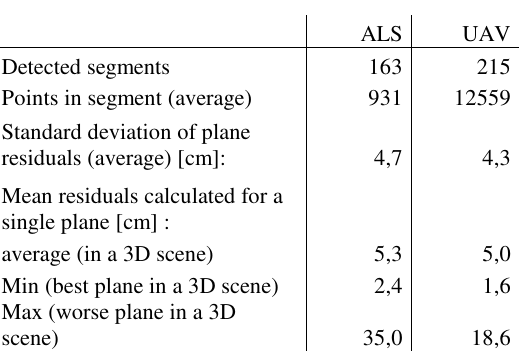
Table 3.1: Statistics on the internal accuracy of 3D reconstruction results.